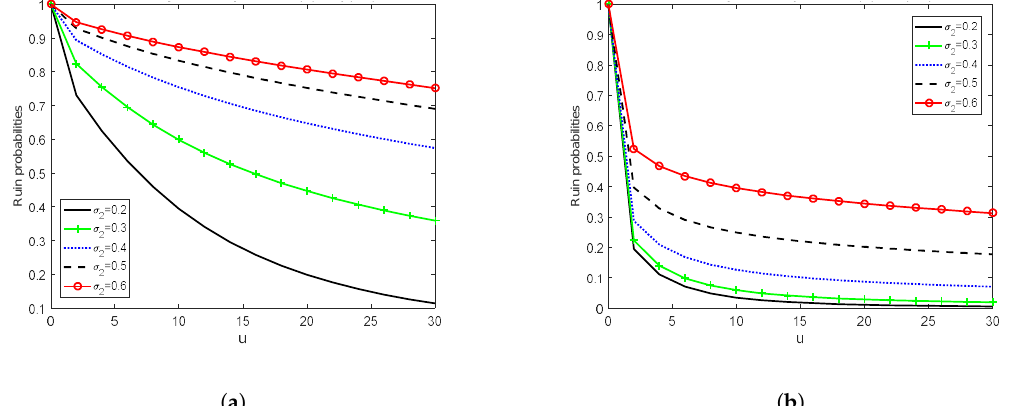
Figure 6. Effects of volatility of stock prices on the ultimate ruin probability in the small and large claim cases; ( a ) Effect of volatility coefficient on ψ ( u ) , Exp(0.5) claims; ( b ) Effect of volatility coefficient on ψ ( u ) , Par(3,2)